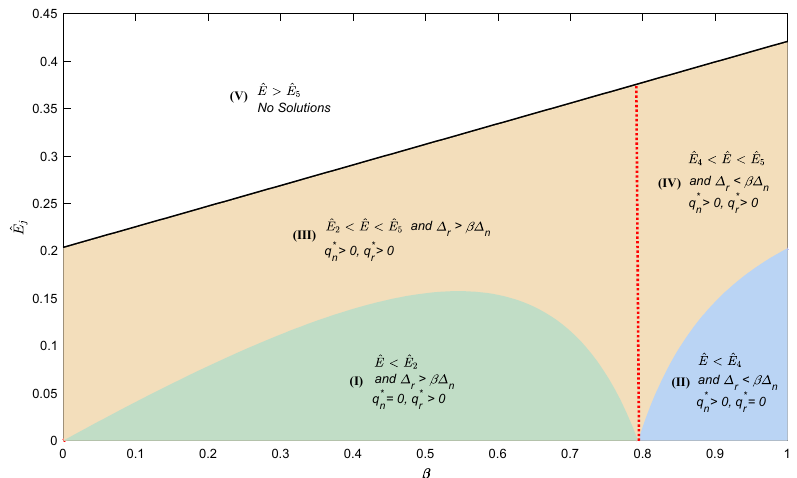
Figure 1. The decision regions of the manufacturer under the carbon credit policy.